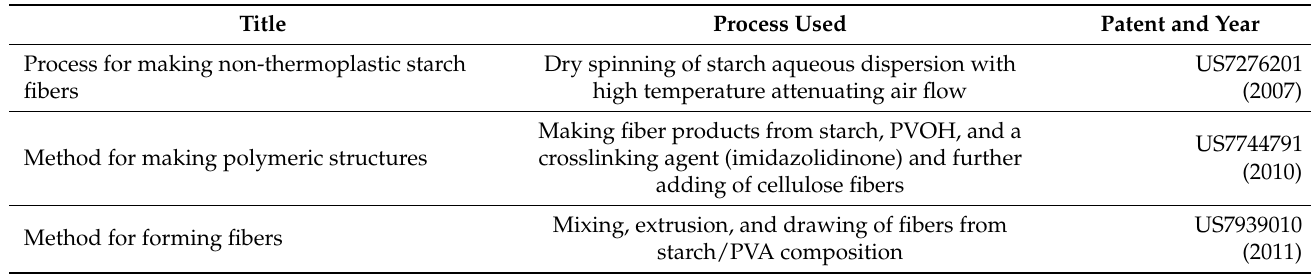
air is used to dry the filaments. Usually, the used solvents in dry spinning are expected to have low boiling point and low latent heat or appropriate volatility, respectively.